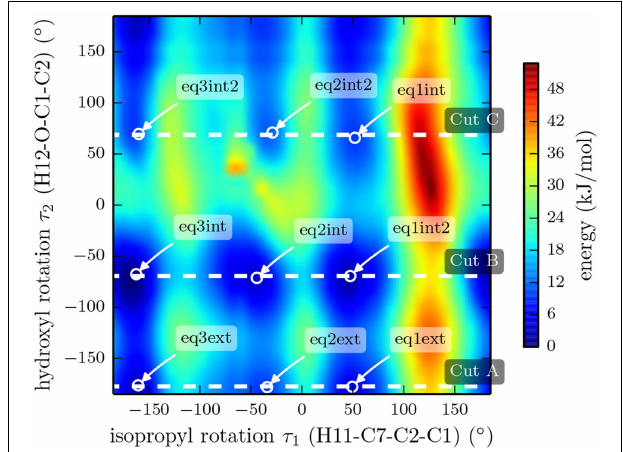
FIGURE 4 | Plot of the potential energy landscape of (-)-menthol as a function of the isopropyl and the hydroxyl dihedral angles. The data was extracted from a two-dimensional, relaxed potential energy scan using the B3LYP/3-21G functional. The dashed lines mark cuts through the 3D surface, which were evaluated using a higher level of theory (B3LYP/6-311 ++ G(d,p)). The results of these three scans are depicted in Figure 5 .